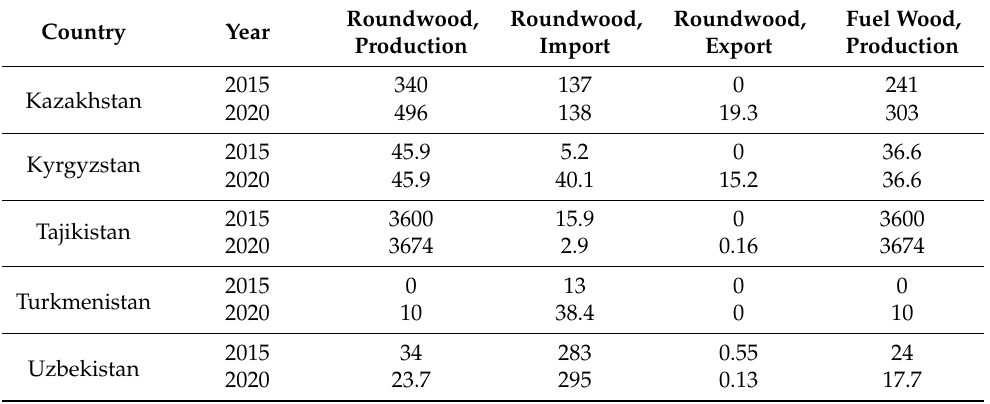
Roundwood, Roundwood, Roundwood, Fuel Wood, Production Import Export Production